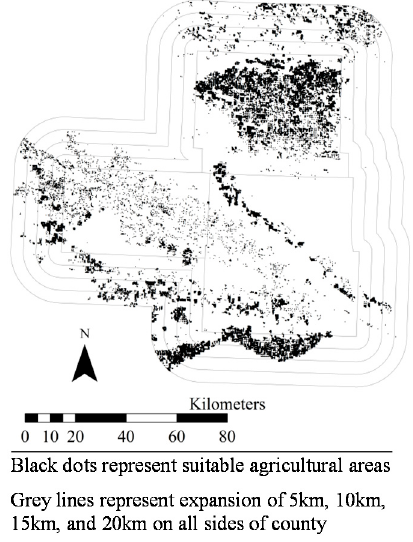
Figure 5. Suitable agricultural land for sweet potatoes in ( a ) Johnston, Nash, Sampson, and Wilson Counties, North Carolina, ( b ) Calhoun County, Mississippi, and ( c ) Merced County, California. Suitable land area for sweet potato production in Calhoun County, Mississippi were identified in this geospatial analysis, but are not clearly visible in Figure 5b due to the small land areas.